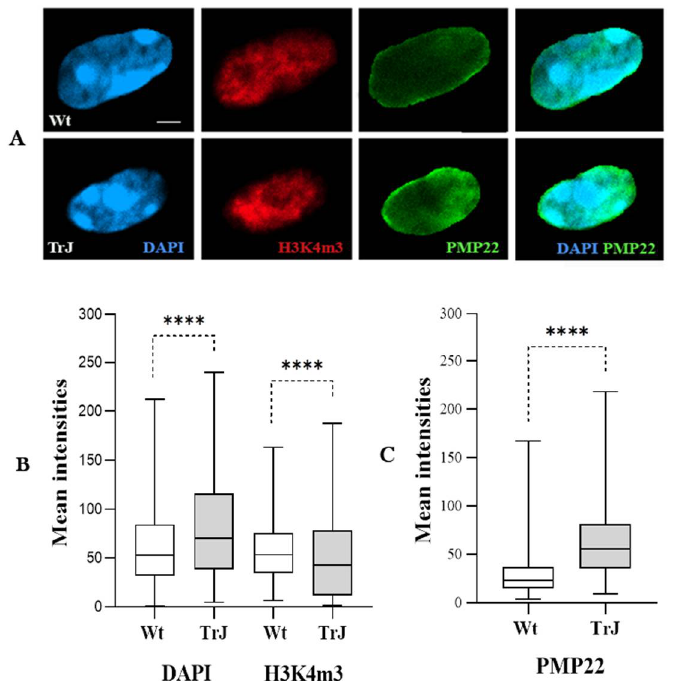
Figure 2. DAPI, H3K4m3, and PMP22 signals in Wt and TrJ Schwann cell nuclei. ( A ): Confocal images of a central slice of a TrJ or Wt SC nucleus. The fibers were immunostained with anti-H3K4m3 (red) anti-PMP22 (green) antibodies, after epitope retrieval (70% formic acid), and counterstained with DAPI (blue). Box plots representing the mean intensity values (arbitrary units) of DAPI and H3K4m3 ( B ) and PMP22 ( C ) signals measured on TrJ and Wt SC nuclei. The boxes containing 50% of the data, presented the median as a transversal line within them. Differences between Wt and TrJ were verified by applying Mann–Whitney tests (**** p -Values < 0.0001) in 150 SC nuclei per genotype. Scale bar = 2 µm. Both Wt and TrJ SC nuclei express PMP22. The intensity of PMP22 was significantly higher in TrJ than in Wt. Furthermore, the overall DAPI intensity of chromatin was significantly higher in TrJ relative to Wt, but the H3K4m3 euchromatic signal intensity was significantly lower in TrJ than in Wt SC nuclei.